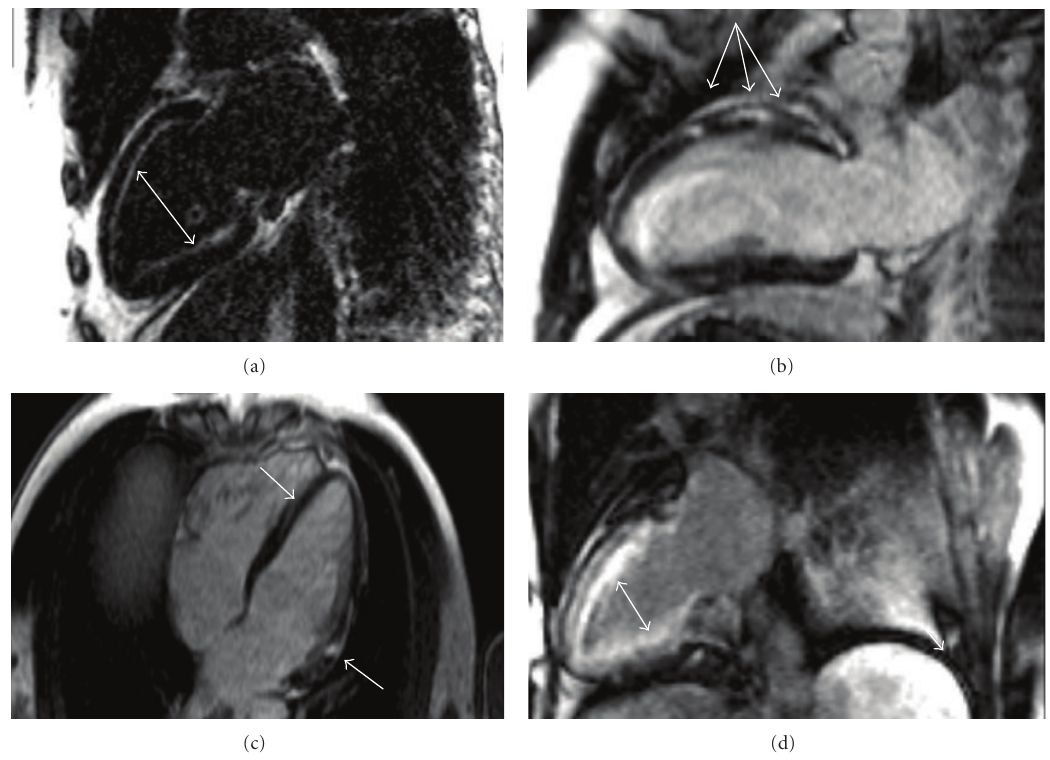
Figure 6: Gadolinium-enhanced imaging in specific cardiac diseases. (a) Subendocardial LGE in a patient with AL amyloidosis. (b) Mid anterior wall focal LGE lesions in a patient with sarcoidosis. (c) Epicardial and mid wall anterior LGE in a patient with myocarditis. (d) Subendocardial enhancement in a patient with Churgg Strauss